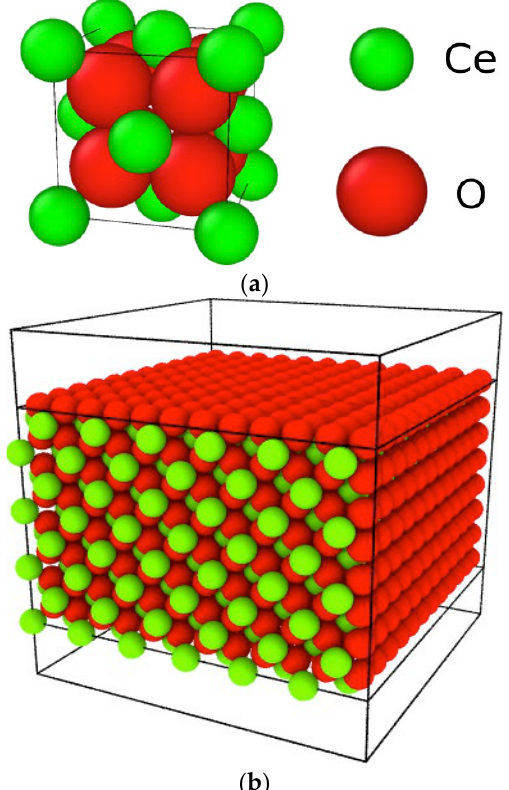
Figure 1. ( a ) The unit structure of CeO 2 fluorite. ( b ) The whole system for calculation.